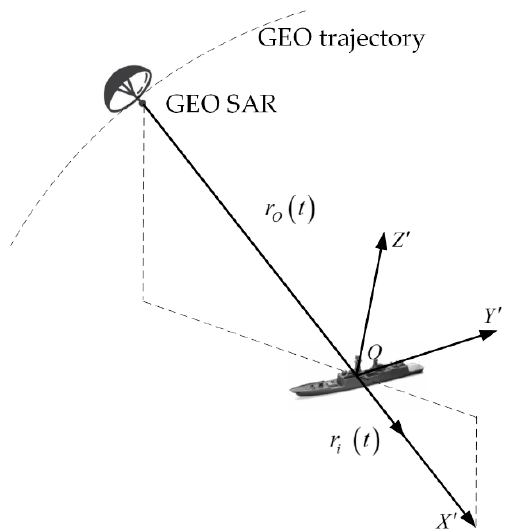
Figure 2. The geometry of a ship and a Geosynchronous Synthetic Aperture Radar (GEO SAR).